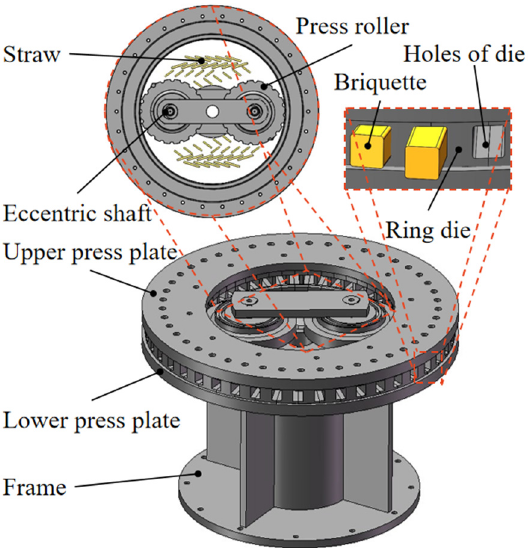
Figure 1. Structure diagram of straw ring die briquetting machine.